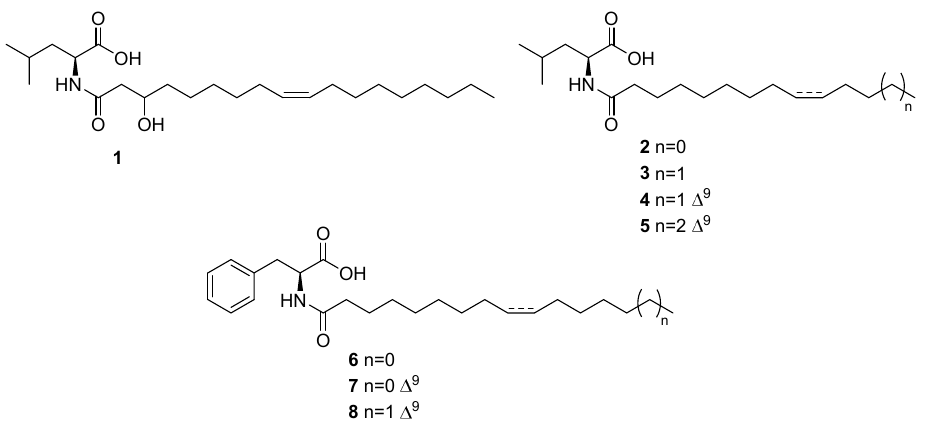
Figure 7. Structures of isolated aminolipids 1–8 .